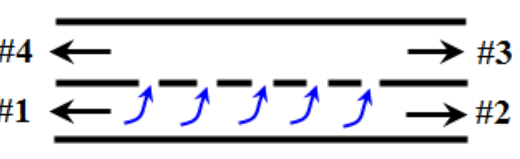
Figure 1. Multi-hole coupling